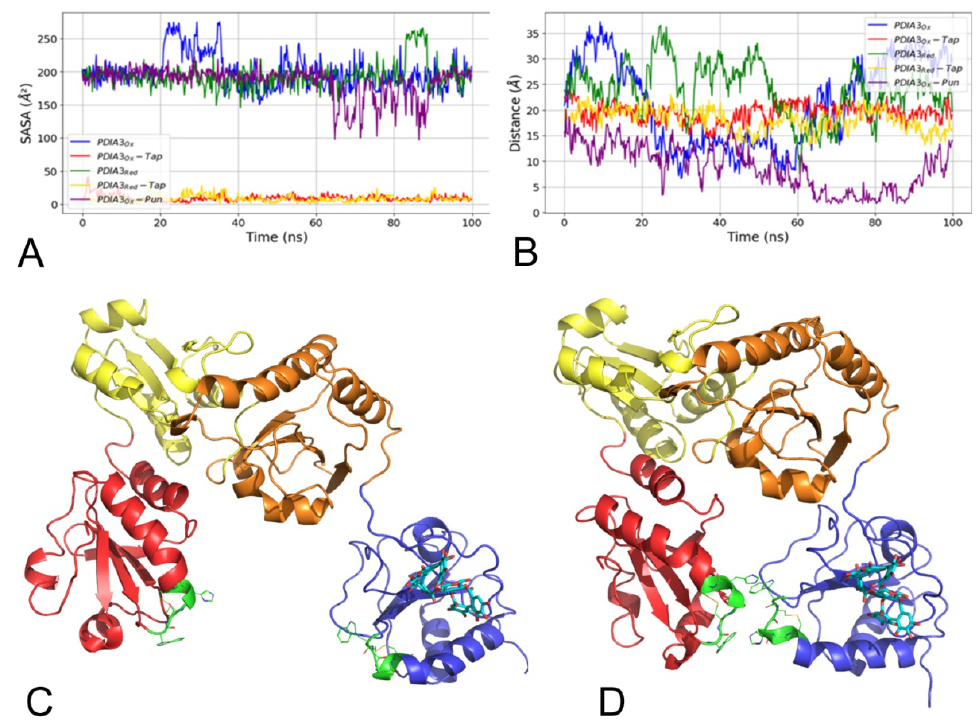
Figure 8. ( A ) Solvent accessible surface area (SASA) time series plot and ( B ) closest distance between a and a’ domains over time plot calculated along MD simulations. ( C ) PDIA3 Ox in “open” and “closed” ( D ) conformation. PDIA3 a domain is depicted in red, b is yellow, b’ is orange, a’ is blue, WCGHC patterns are green lines while punicalagin is depicted as cyan sticks.